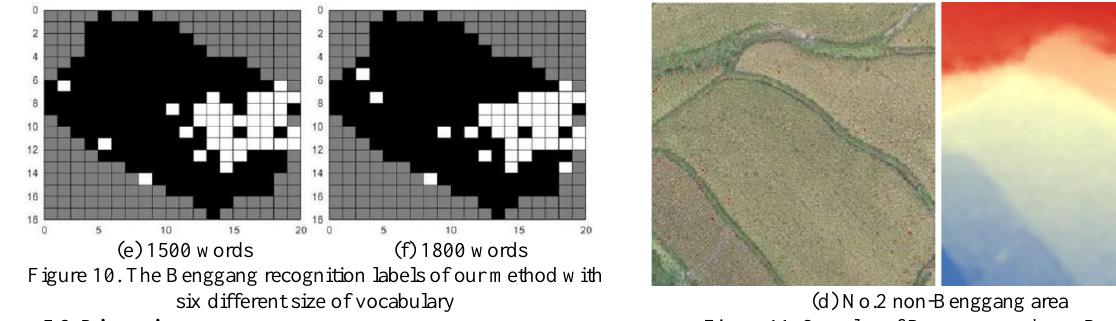
Figure 11. Samples of Benggang and non-Benggang